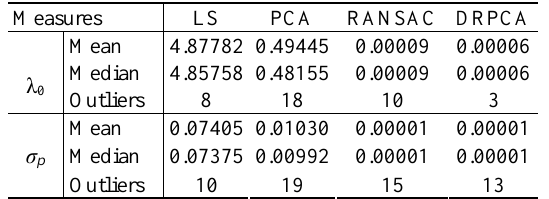
Table 2. Measures based on λ 0 and σ p from 1000 runs